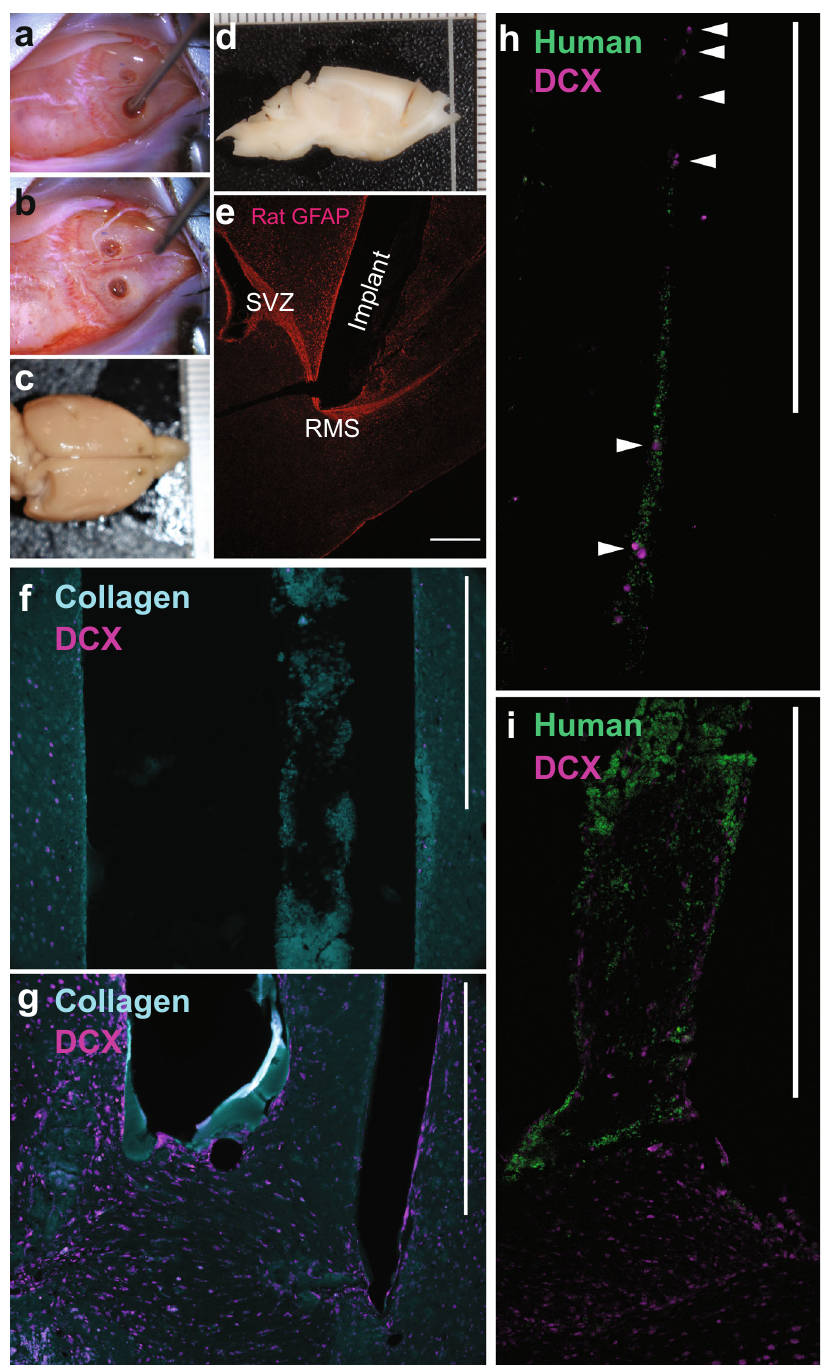
Fig. 7 Implantation of human TE-RMSs in the brains of athymic rats demonstrates surgical feasibility and proof of principle for redirecting neuroblast migration. Pairs of human GMSC-derived TE-RMSs and acellular collagen controls were bilaterally implanted into the brains of athymic rats using precise stereotaxic coordinates to span RMS and cortex. Images captured during ( a ) and after ( b ) bi-lateral stereotactic implantation of TE-RMS. Gross pathology of the formalin- fi xed brain from the top ( c ) and side ( d ) view (note that d is blocked to show the implant trajectory). Immunolabelling rat GFAP demonstrating accurate placement of TE-RMS contacting the RMS ( e ). Immunolabelling showing labelling of collagen within the acellular control implant and DCX positive host cells present in the surrounding tissue but absent from the collagen implant midway through the column ( f ; ~3 mm from RMS), and present in the collagen at the interface with the endogenous RMS ( g ). Immunolabelling showing non-overlapping colabeling of human nuclei of the TE-RMS astrocytes and DCX positive (Human negative) host neuroblasts migrating through the TE-RMS midway through the implant ( h ; ~3 mm from RMS; white arrows indicate DCX + /Human − cells), and at the interface between TE-RMS and host RMS ( i ). Scale bars: 500